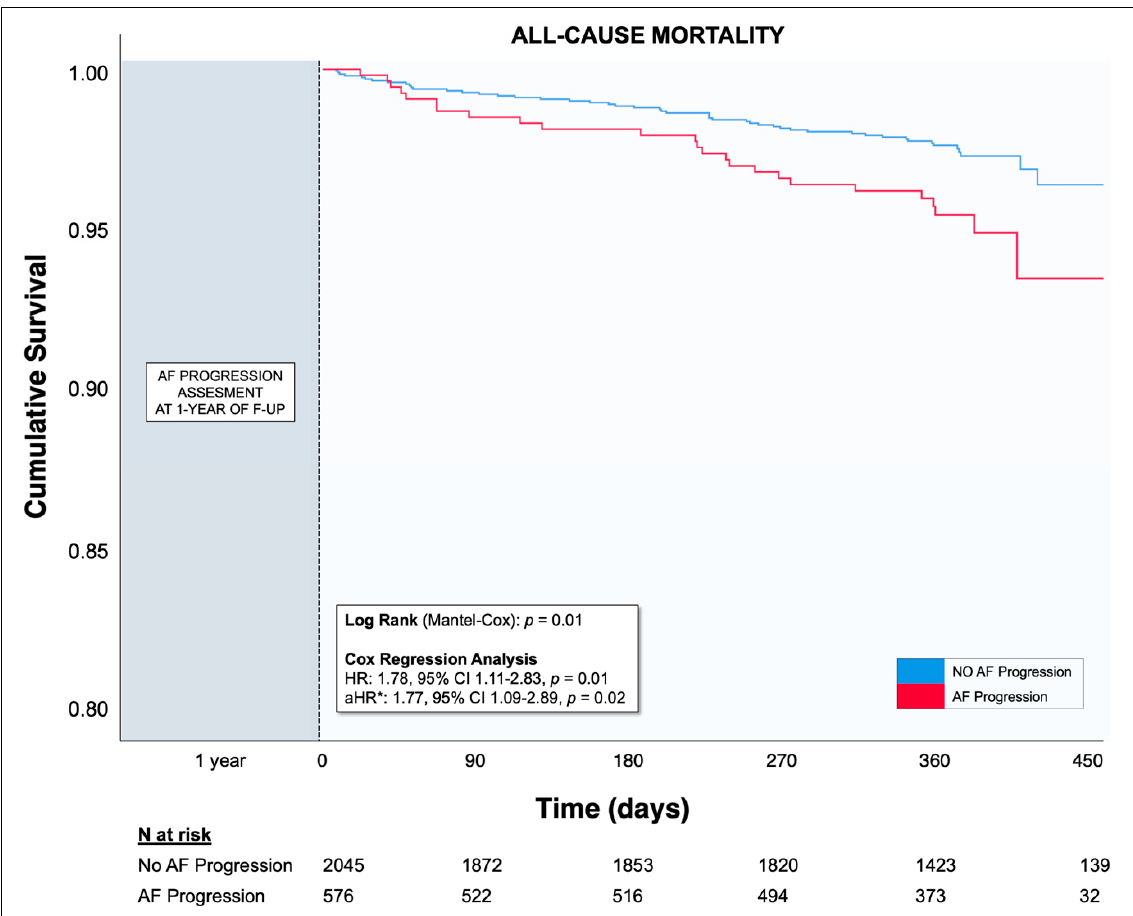
Figure 2. Kaplan-Meier curves for the primary endpoint (all-cause death) for patients with or without AF progression during the extended follow-up (i.e., after AF progression assessment at 1-year). aHR = adjusted hazard ratio; AF = atrial fibrillation; CI confidence interval; F-UP = follow-up; HR, hazard ratio; N = number. * The Cox regression analysis was adjusted for age, sex, heart failure, coronary artery disease, hypertension, diabetes mellitus, previous thromboembolic events, peripheral artery disease, chronic kidney disease, and use of oral anticoagulants. Table 4. Major adverse events at 2 years of follow-up according to AF progression status at 1 year.